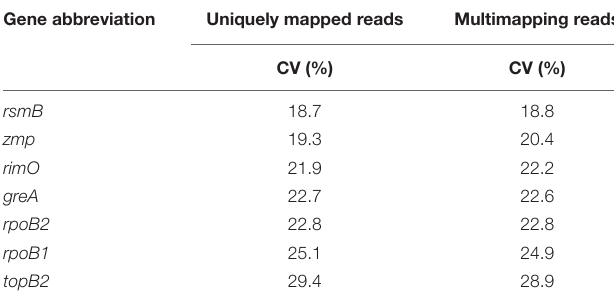
TABLE 4 | Coefficient of variation of transcript per million (TPM) values from both count tables (uniquely mapped reads and multi-mapping